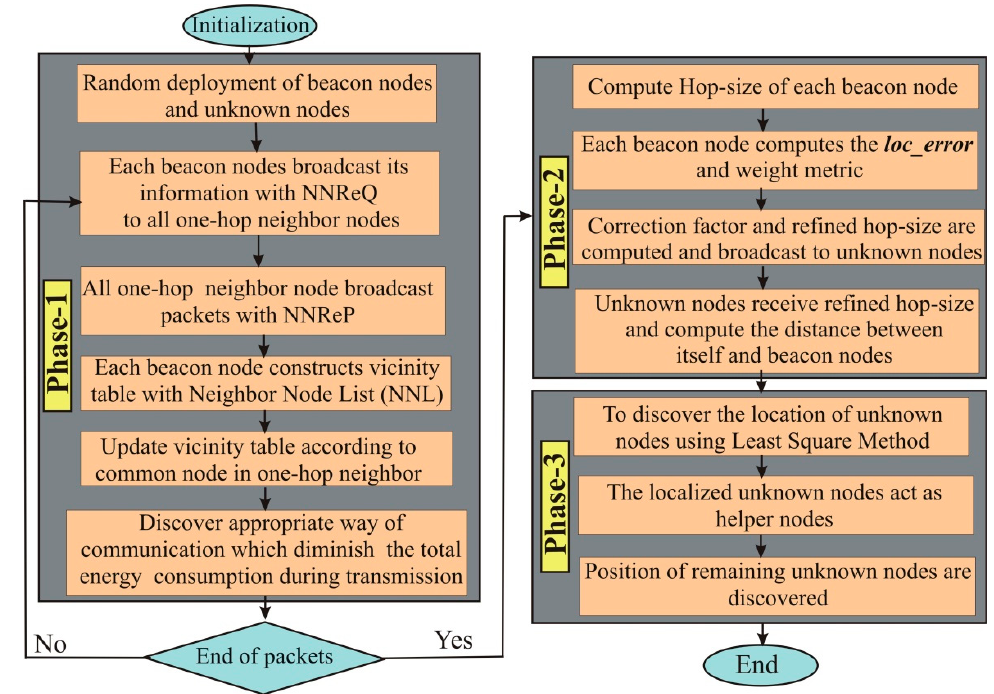
Figure 2. Flowchart of the proposed methodology. Nearest Neighbor Request (NNReQ) and Nearest Neighbor Reply (NNReP).